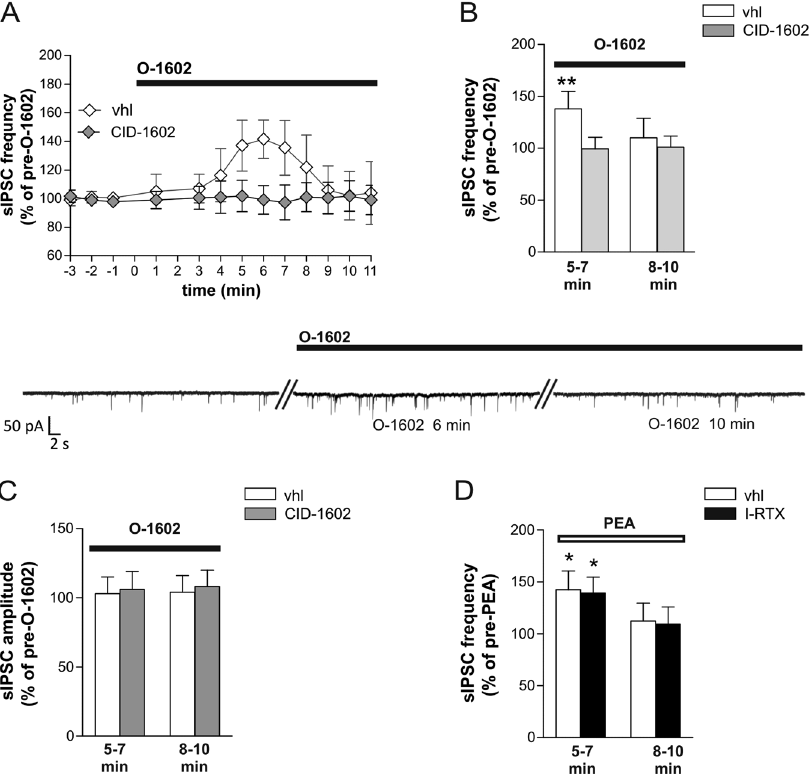
Figure 2. Effect of GPR55 on striatal GABAergic synaptic transmission. ( A,B ) O-1602 caused a rapid and transient increase of sIPSC frequency. Preincubation with CID-1602 prevented the action of O-1602 on sIPSC frequency. The electrophysiological traces on the bottom are examples of voltage-clamp recordings before and during the application of O-1602. ( C ) sIPSC amplitude was unchanged during bath application of O-1602 when applied alone or in the presence of CID-1602. ( D ) Preincubation with the TRPV1 antagonist I-RTX did not affect the PEA-mediated alteration on sIPSC